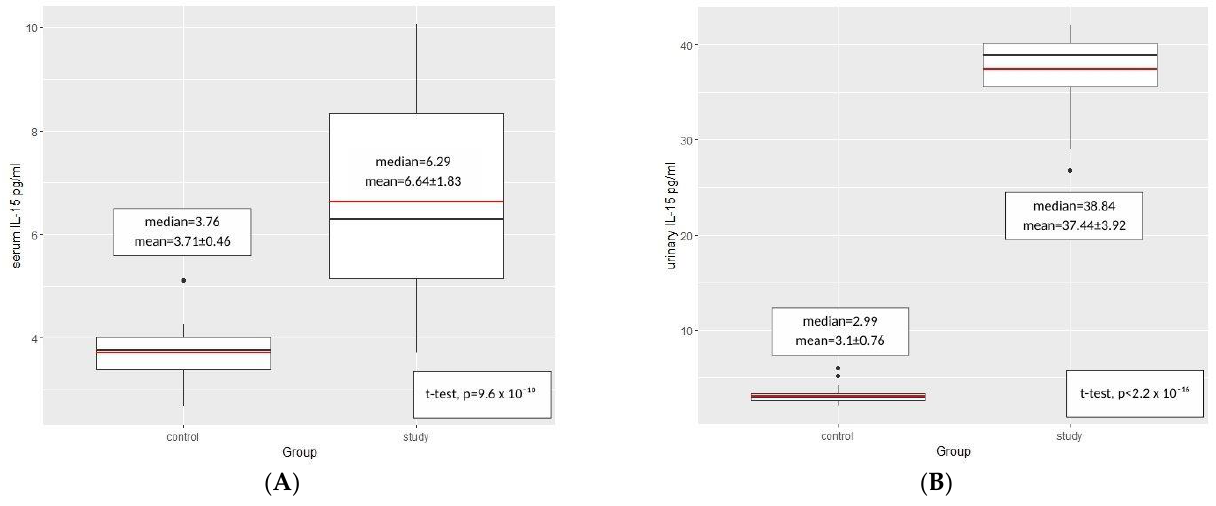
Figure 2. IL-15 concentration comparison between the control group and the study group in serum ( A ) and urine ( B ) (student’s t-test for independent samples). Red line represents mean value and black line represents the median.